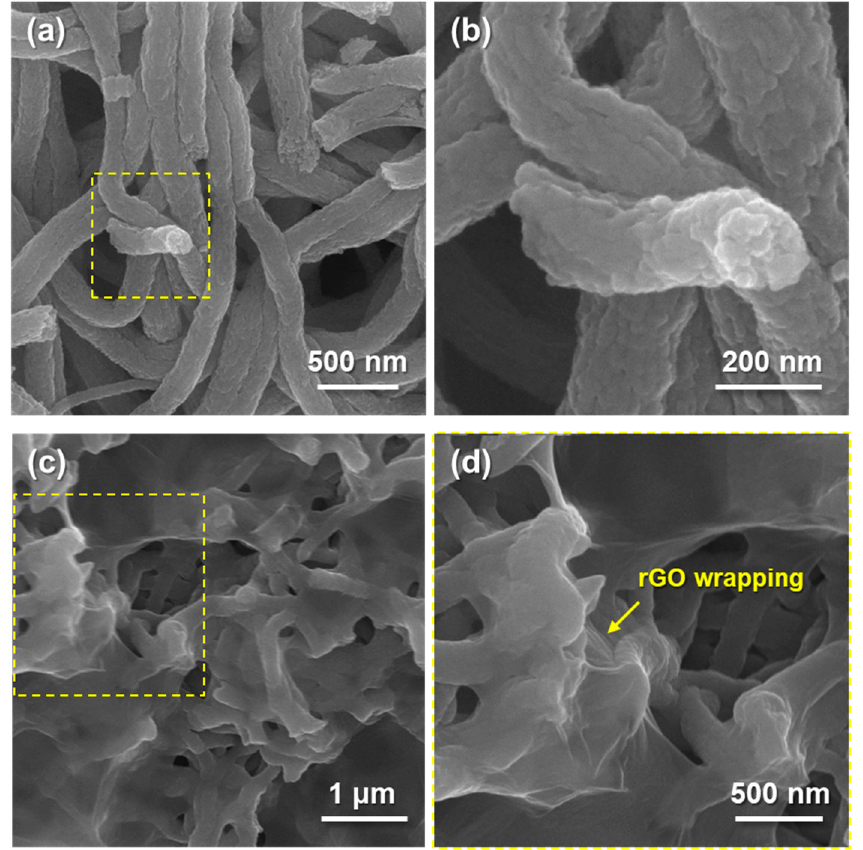
Figure 2. SEM images of ( a ) MoS 2 @CNFs and ( b ) MoS 2 @CNFs@rGO, HR-SEM images of ( c